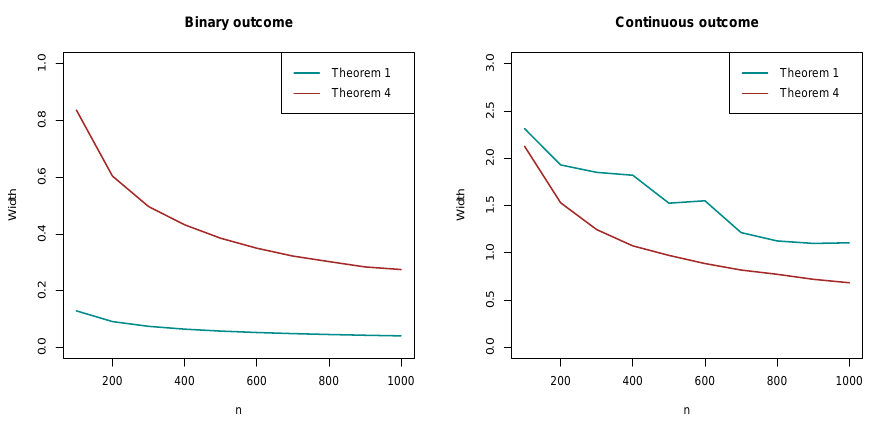
Figure 1. Width of the error bounds with the increasing of sample sizes (using true